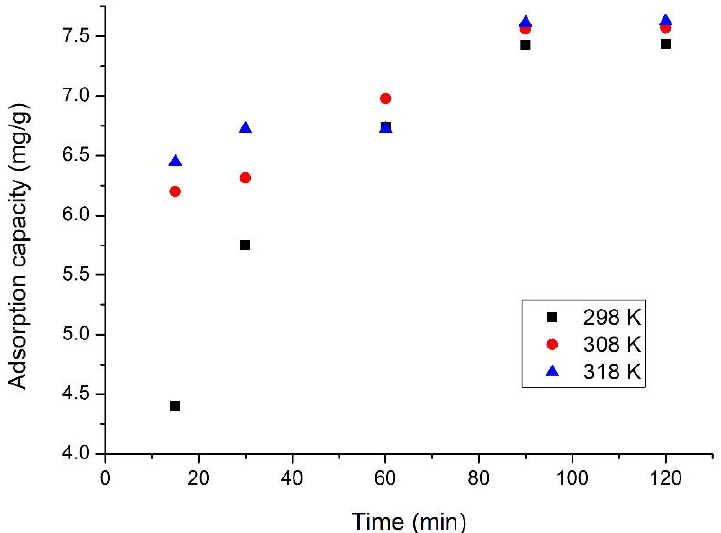
Figure 8. Effect of contact time and temperature on the V(V) recovery.